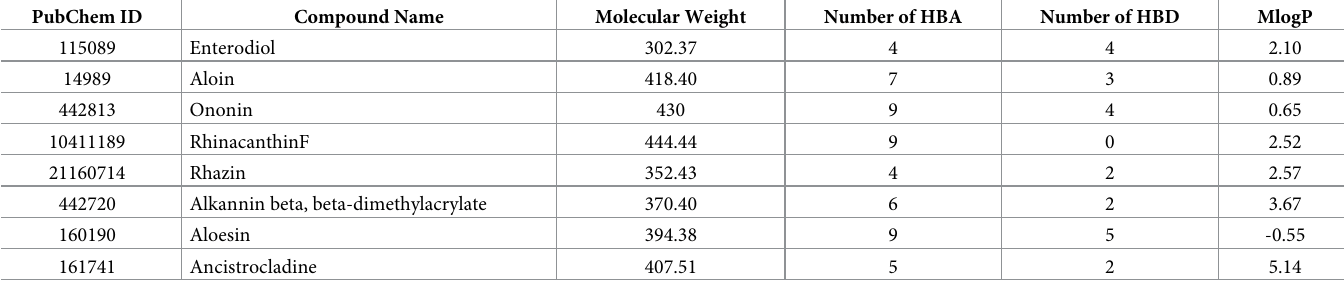
Table 5. Results of inhibitors examined for Lipinski